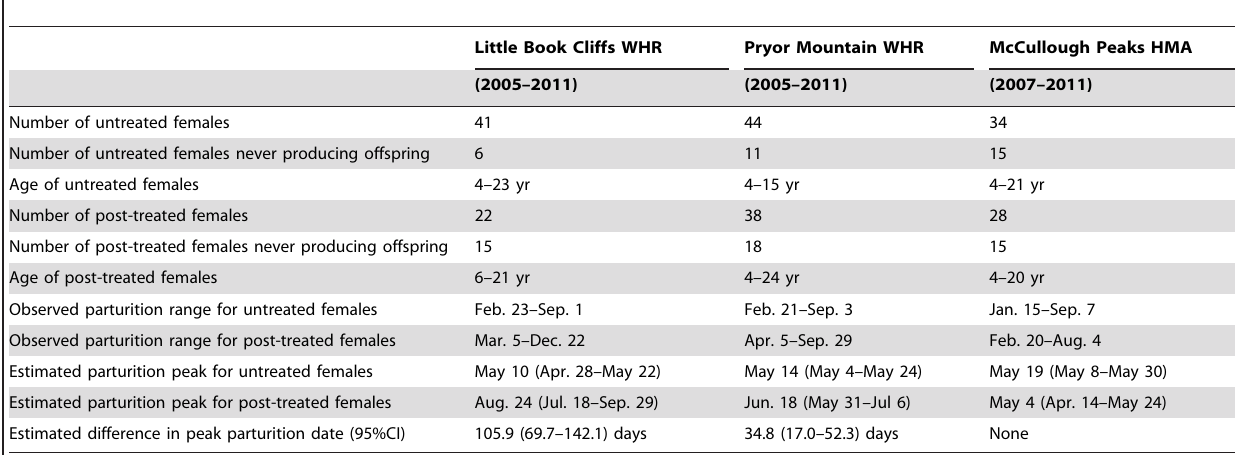
Table 1. Parturition data from untreated and porcine zona pellucida (PZP) treated female feral horses ( Equus caballus ) at Little Book Cliffs Wild Horse Range, CO, Pryor Mountain Wild Horse Range, MT, and McCullough Peaks Herd Management Area, WY,